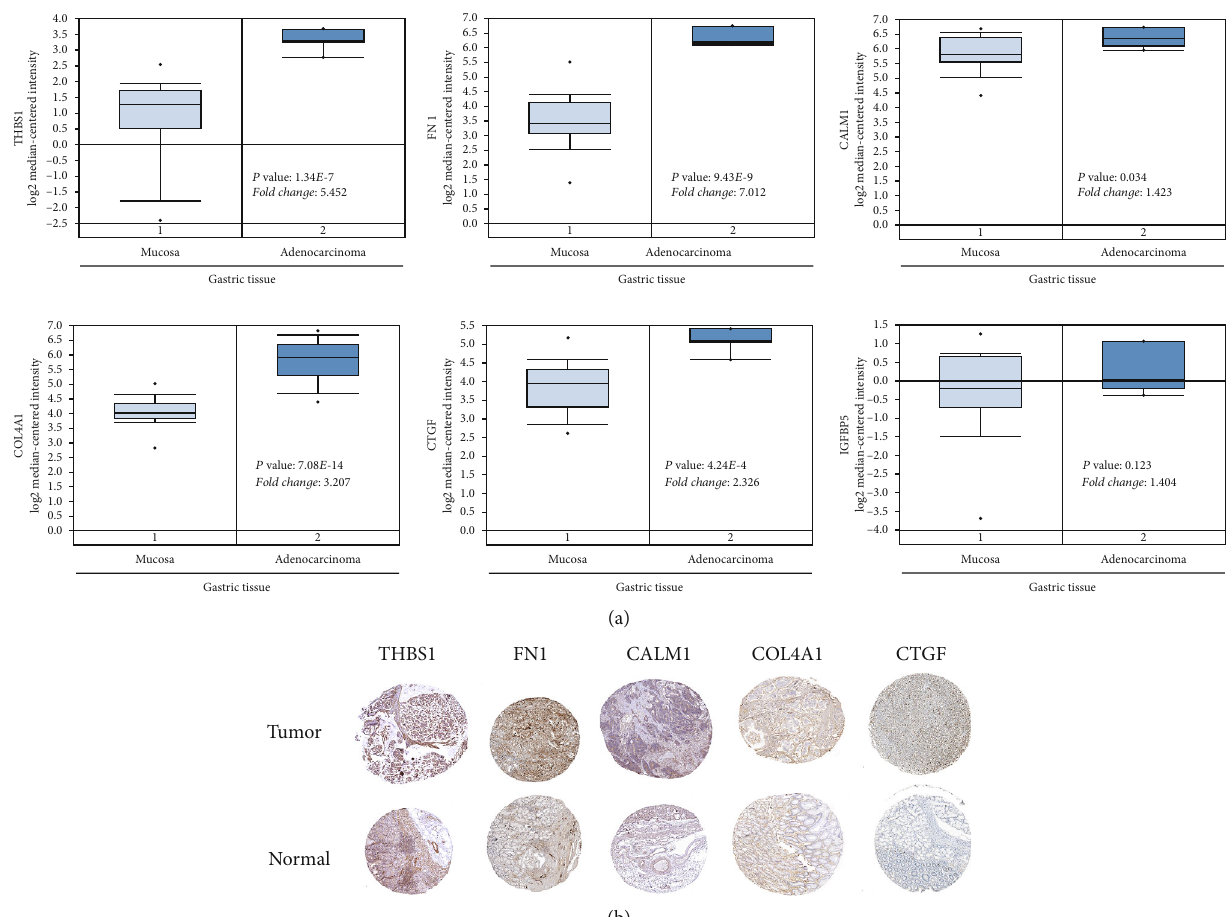
Figure 8: mRNA and protein expression levels of THBS1, FN1, CALM1, COL4A1, CTGF, and IGFBP5 for clinical signi fi cance in GC: (a) Oncomine data mining showing that THBS1, FN1, CALM1, COL4A1, CTGF, and IGFBP5 mRNA expression levels in Derrico datasets di ff er between normal mucosa and gastric adenocarcinoma tissues; (b) protein levels of THBS1 in normal tissue (staining: high; intensity: strong; quantity: > 75%). Protein levels of FBXO5 in tumor tissue (staining: high; intensity: strong; quantity: > 75%). Protein levels of FN1 in normal tissue (staining: low; intensity: moderate; quantity: < 25%). Protein levels of FN1 in tumor tissue (staining: medium; intensity: moderate; quantity: 75%-25%). Protein levels of CALM1 in normal tissue (staining: medium; intensity: moderate; quantity: 75%-25%). Protein levels of CALM1 in tumor tissue (staining: medium; intensity: moderate; quantity: 75%-25%). Protein levels of COL4A1 in normal tissue (staining: not detectable; intensity: negative; quantity: negative). Protein levels of COL4A1 in tumor tissue (staining: medium; intensity: moderate; quantity: 75%-25%). Protein levels of CTGF in normal tissue (staining: low; intensity: moderate; quantity: rare). Protein levels of CTGF in tumor tissue (staining: low; intensity: weak; quantity: >